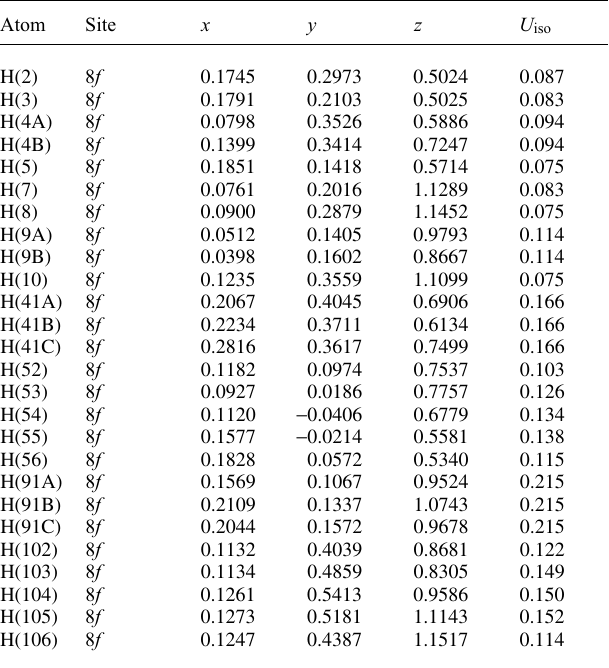
Table 2. Atomic coordinates and displacement parameters (in Å 2 )